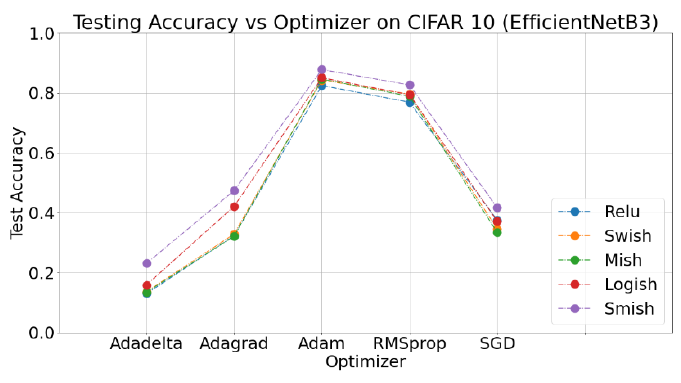
Figure 8. Test accuracy vs. optimizer.